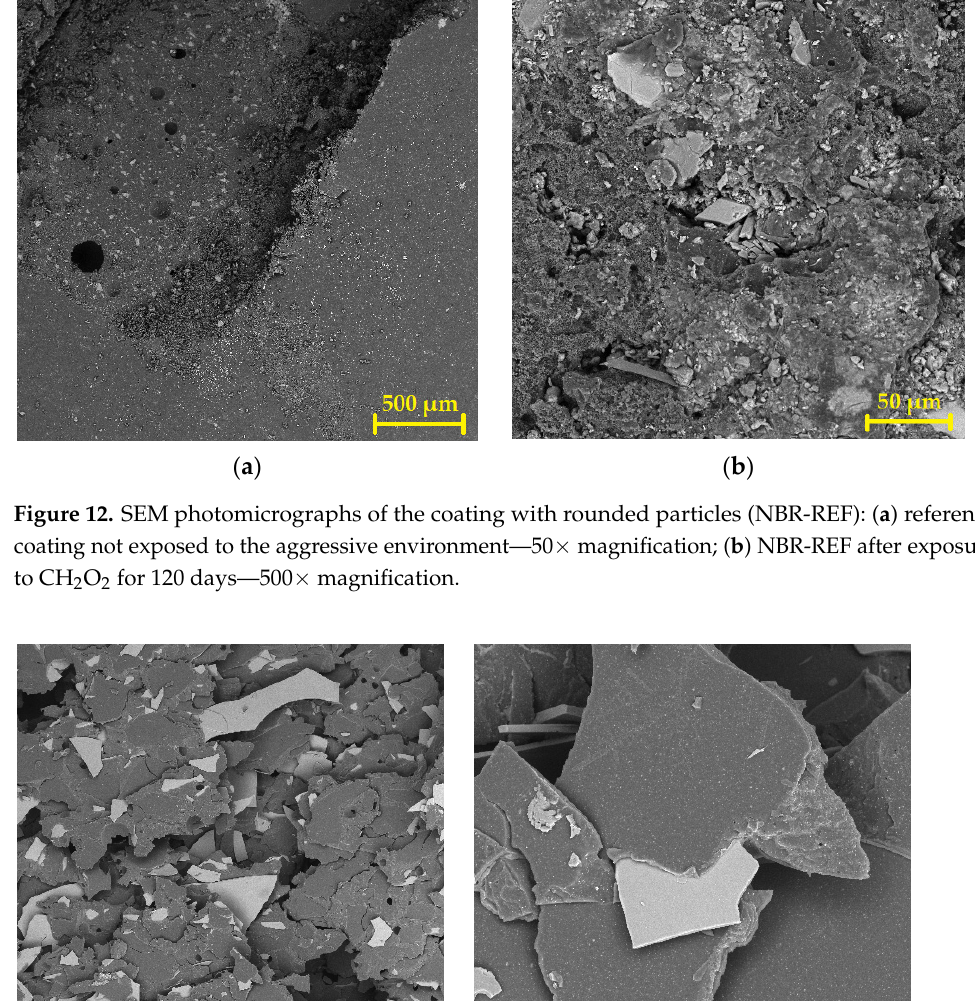
Figure 12. SEM photomicrographs of the coating with rounded particles (NBR-REF): ( a ) reference coating not exposed to the aggressive environment—50× magnification; ( b ) NBR-REF after exposure to CH 2 O 2 for 120 days—500× magnification.